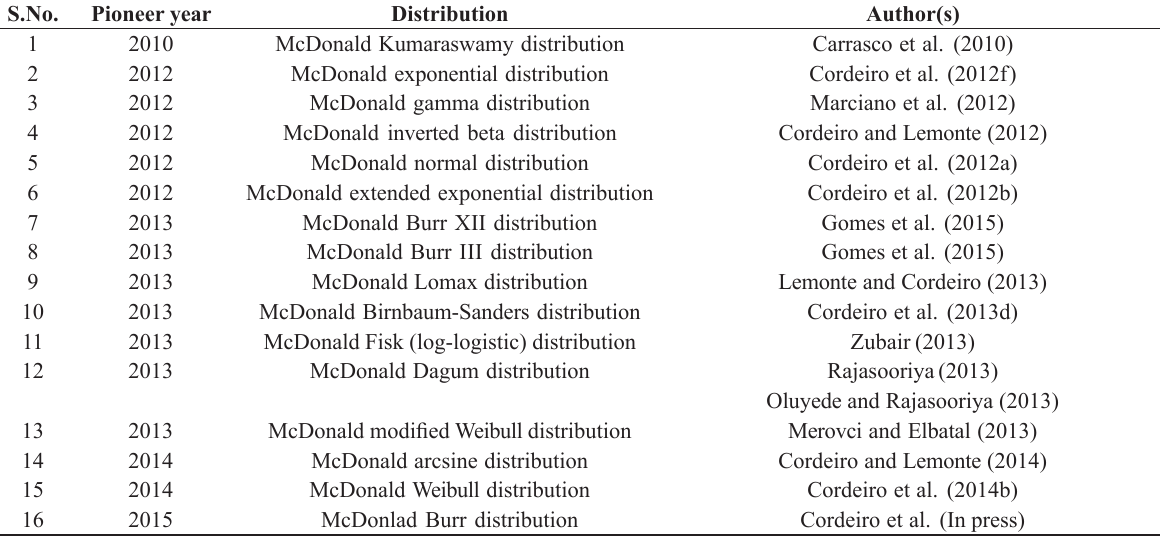
Contributed work on the Mc G family of